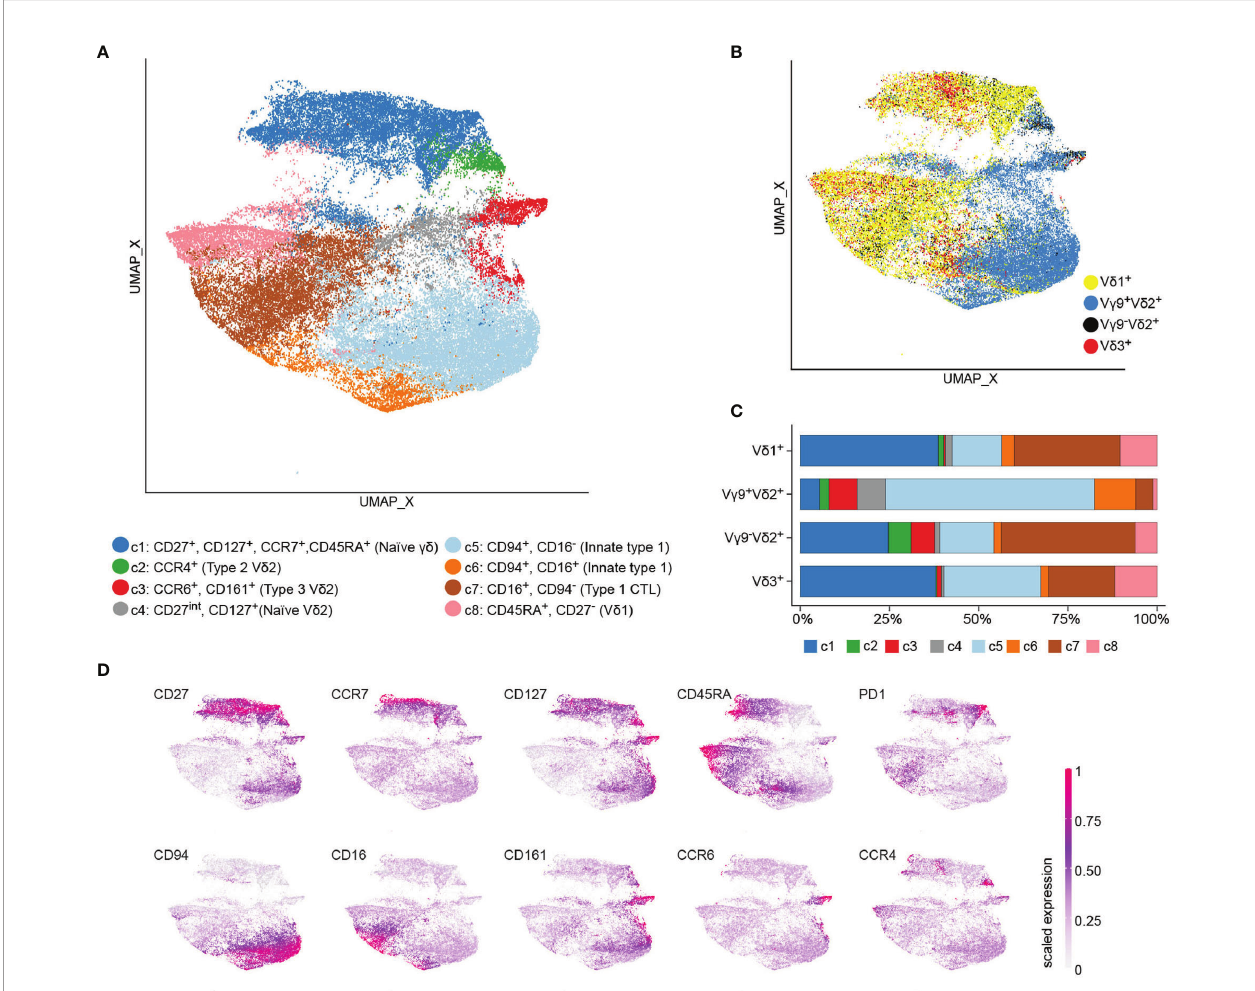
FIGURE 1 | Flow cytometry data reveals heterogeneity across gd T cell subsets. Peripheral blood mononuclear cells of children with malaria (n=25), non-infected children (n=27) from Ghana, Ghanaian non-infected adults (n=10), and European cord blood donors (n=6) were stained with a 17-color antibodies panel to delimit gd T cell subsets. Flow cytometry data of gd T cells were subjected to unsupervised clustering, down sampled and visualized by UMAP, where each point represents a single cell. (A) UMAP color-coded by cluster. (B) Single cells colored-code by being V d 1 + , V g 9 + V d 2 + , V g 9 - V d 2 + or V d 3 + . (C) The proportion of each cluster was calculated for the total number of V d 1 + , V g 9 + V d 2 + , V g 9 - V d 2 + or V d 3 + T cells of all included subjects. (D) Expression values of the ten surface markers were scaled to a range between 0 and 1 and projected on UMAP.